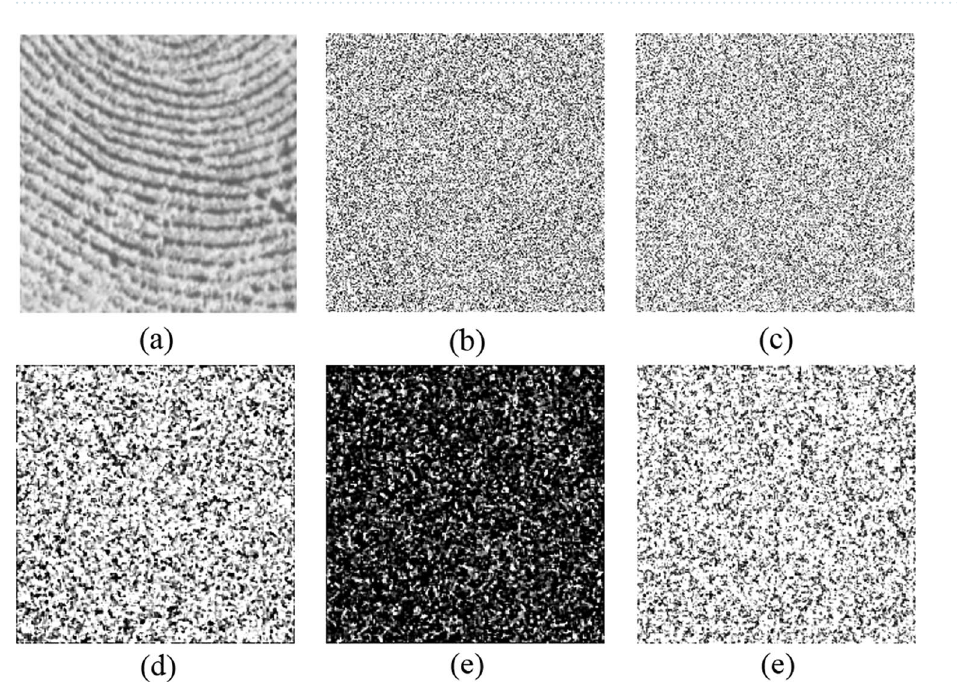
Figure 5. ( a ) Image to be encrypted, g ; ( b ) final decrypted image H de ; ( c , d ) are two parts of the mapped hologram of ‘goat’, i.e., H Bc and H Bs respectively; ( e , f ) are encrypted images, c x and c y , respectively; ( g ) reconstruction cosine hologram H Bc ; ( h ) reconstruction sine hologram H Bs ; ( i ) and ( j ) are cosine and sine pinhole holograms H Bc and H Bs ,